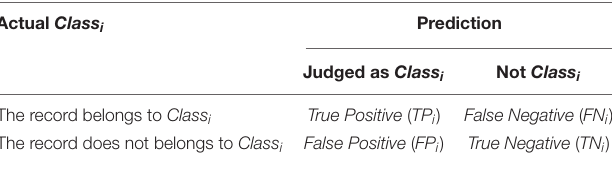
TABLE 1 | Contingency table for binary classification problems. Actual Class